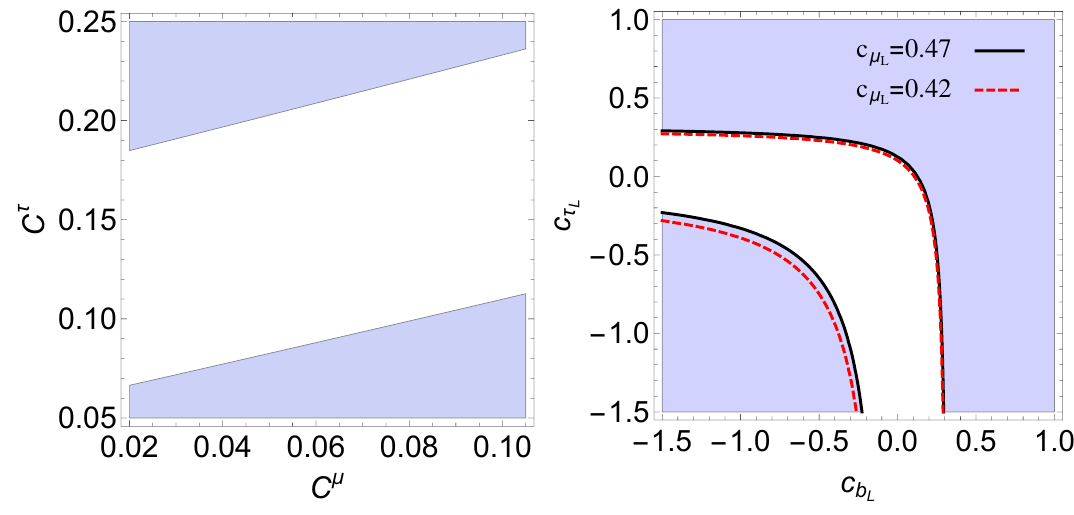
Figure 16 . Left panel: allowed region in the plane ( C (cid:22) ; C (cid:28) ) at the 95% CL. Right panel: cor- responding allowed region in the ( c b ; c (cid:28) ) plane at the 95% CL coming from the ( R D ; R D (cid:3) ) ob- L L servables. We have considered c (cid:22) = 0 : 47 (black lines and shaded area). We also display the limit L of the allowed region for the case c (cid:22) = 0 : 42 (dashed red lines). We have considered r = 0 : 75, L m KK = 2 TeV, and c q = 0 : L